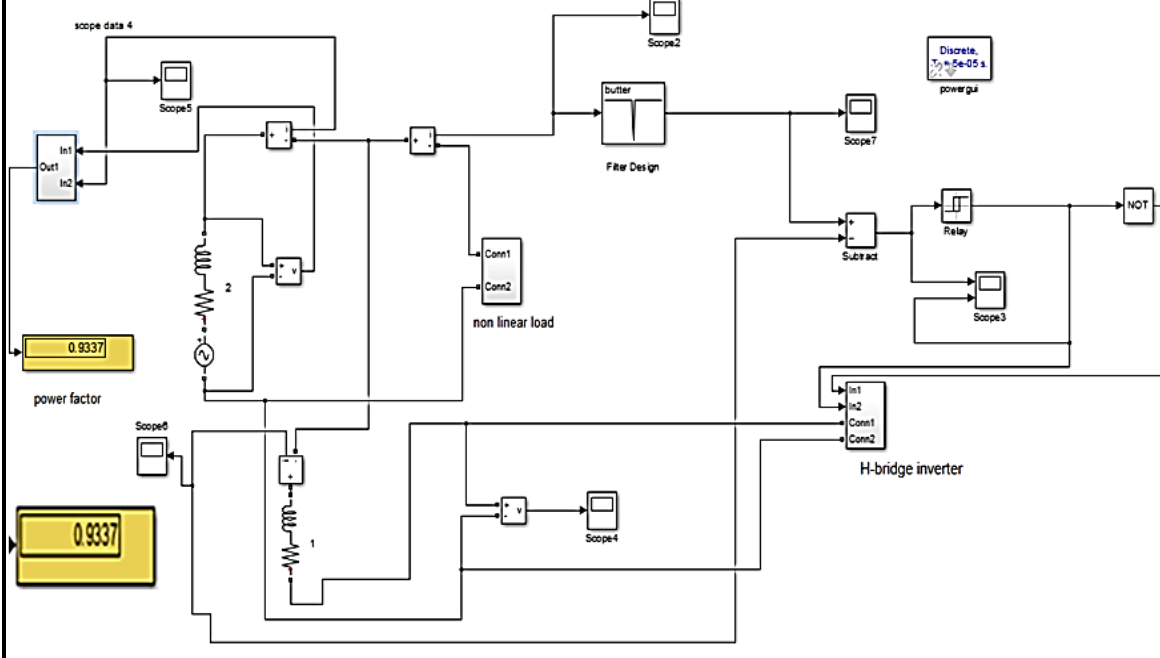
Figure 6. Simulated power factor circuit in MATLAB/ Simulink environment.